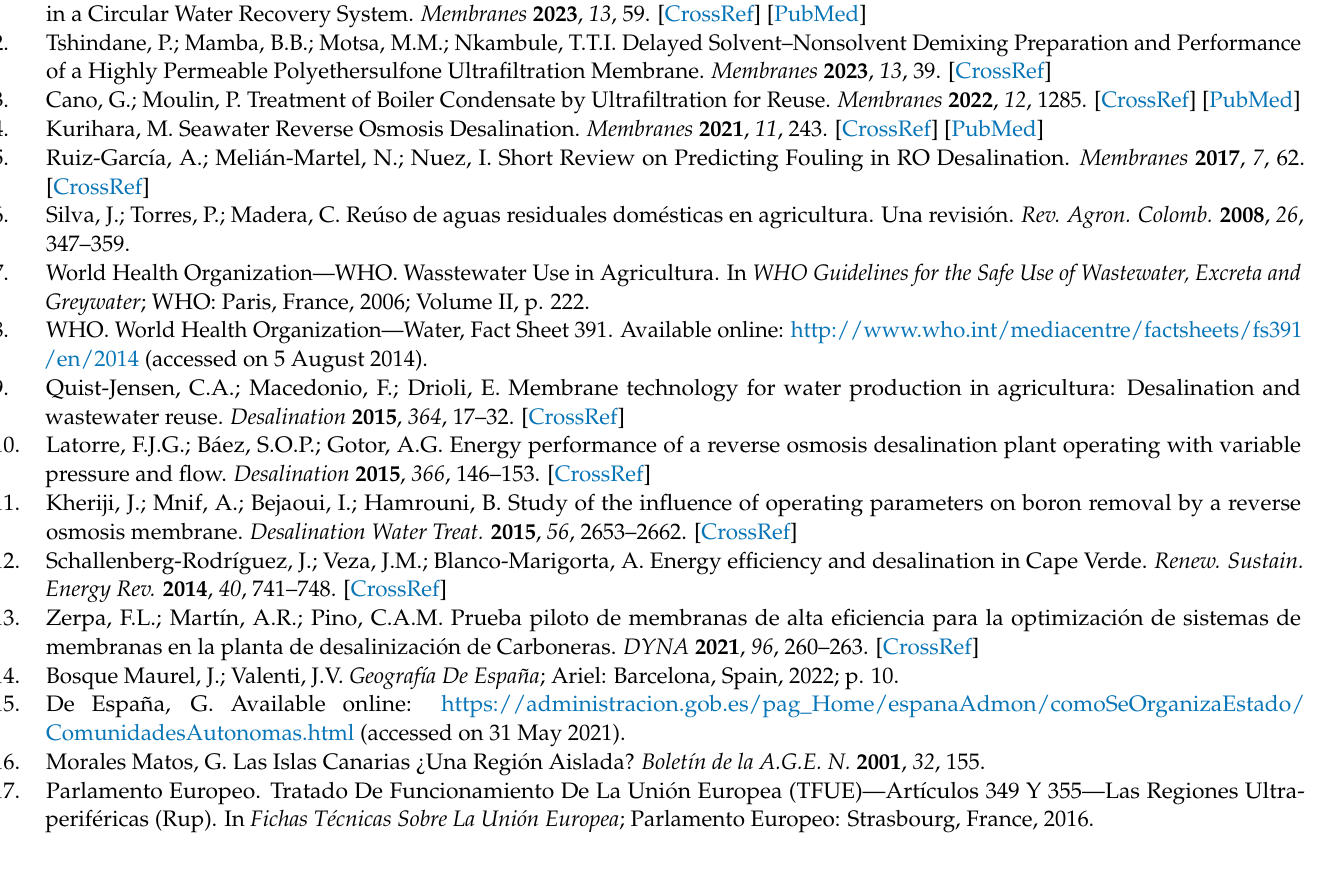
Figure A13. Flow and permeate turbidity at 105 L/m 2 h.